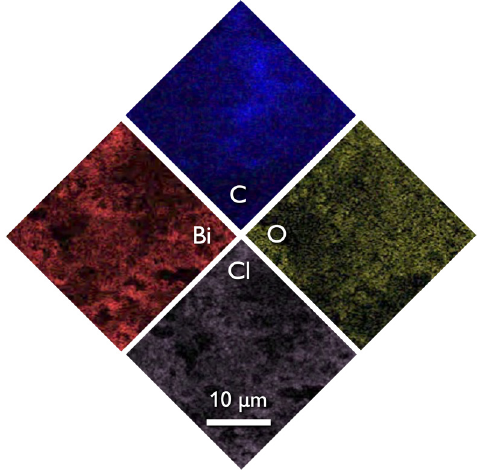
Figure 4. The SEM image of EDX spectroscopy of